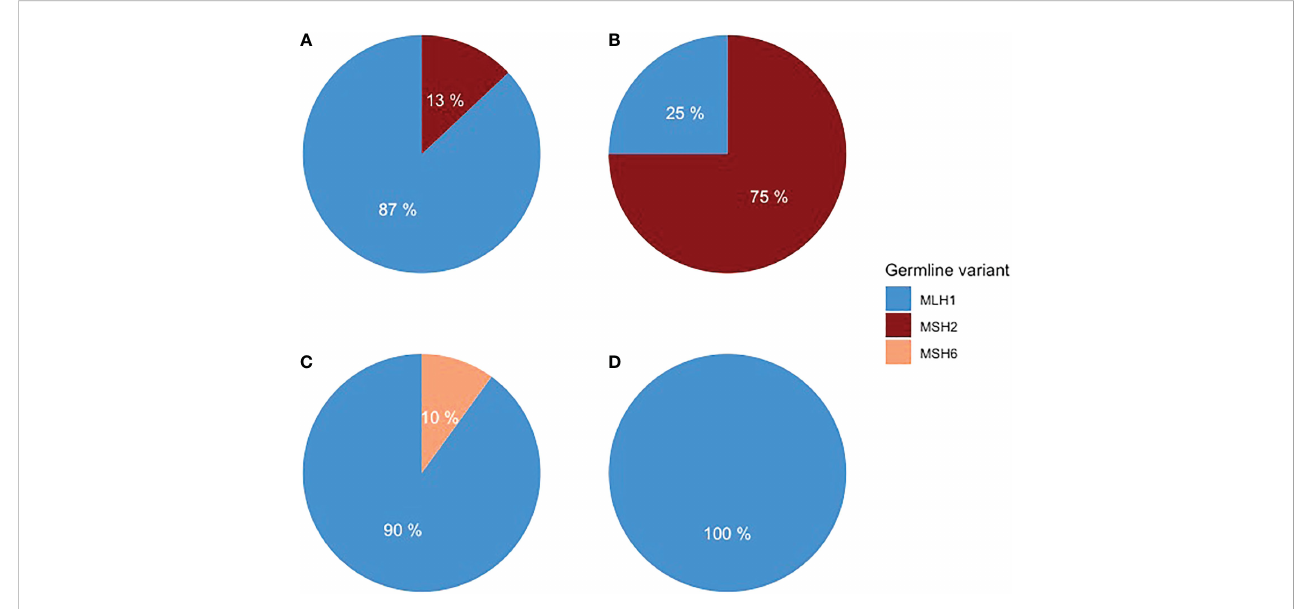
Table 1. Five families had more than one family member diagnosed with PC or BTC.